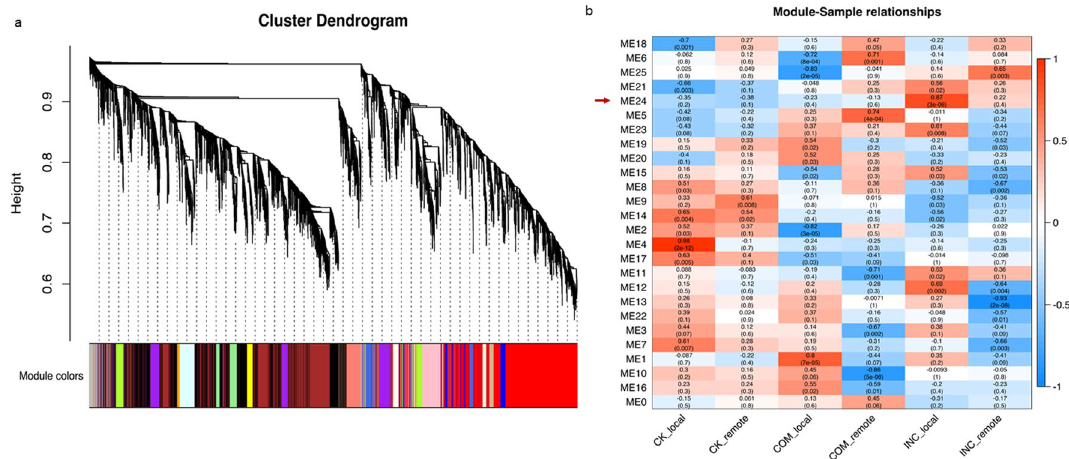
Figure 7. Weighted gene co-expression network analysis (WGCNA) across all treatments. ( a ) Hierarchical clustering tree (dendrogram) of DEGs with dissimilarity based on the topological overlap. Each color represents module eigengene, and each column corresponds to a treatment. Each cell contains a corresponding correlation (top) and p -value (bottom). The color scheme, from red through white to blue, indicates the level of